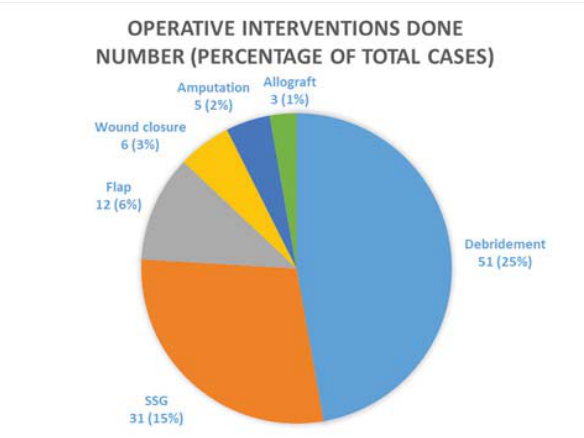
Figure 13. Patient distribution according to operations